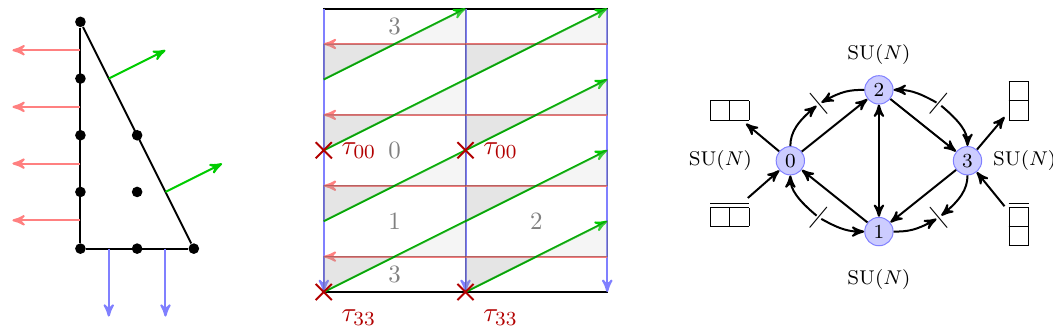
Figure 25. The model L 0 , 4 , 0 / Z 2 . On the left the toric diagram is drawn, at the center the five- brane and its orientifold projection with fixed points, on the right the quiver resulting from the orientifold